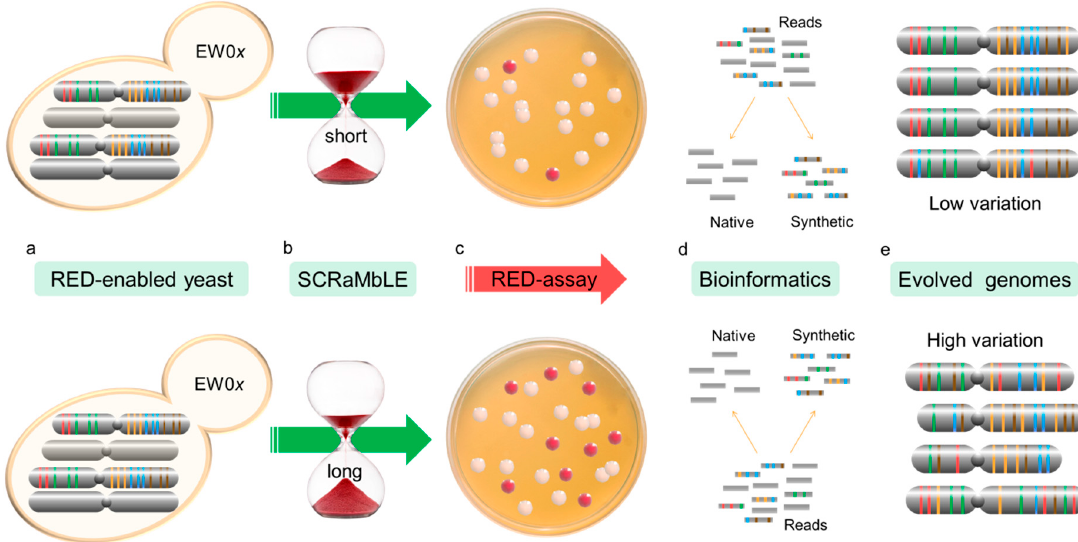
Figure 2. Flow diagram of the RED assay experimental procedure. RED-enabled semi-synthetic heterozygous diploid cells, containing a synthetic copy of chr III and VI, were engineered to turn red due to loxP-mediated loss of ADE2 ( a ). Cre-recombinase expression was induced for 2, 4 and 6 h to allow increased genomic rearrangement through SCRaMbLE ( b ). The frequency of ADE2 loss was determined based on the appearance of yeast colonies with red pigment ( c ). Randomly selected colonies were sequenced using short-read NGS technology. Custom scripts were developed to filter out all reads not originating from the synthetic genomes ( d ). SCRaMbLEd chromosomes were assembled and assessed for gene loss ( e ).